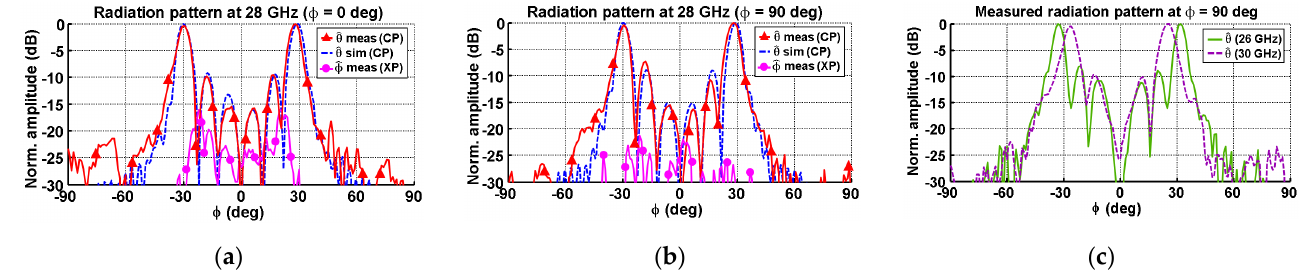
Figure 13. Conformal array antenna normalized radiation patterns: ( a ) simulated and measured ϕ = 0° patterns at 28 GHz; ( b ) simulated and measured ϕ = 90° patterns at 28 GHz; and ( c ) measured ϕ = 90° patterns at 26 and 30 GHz.